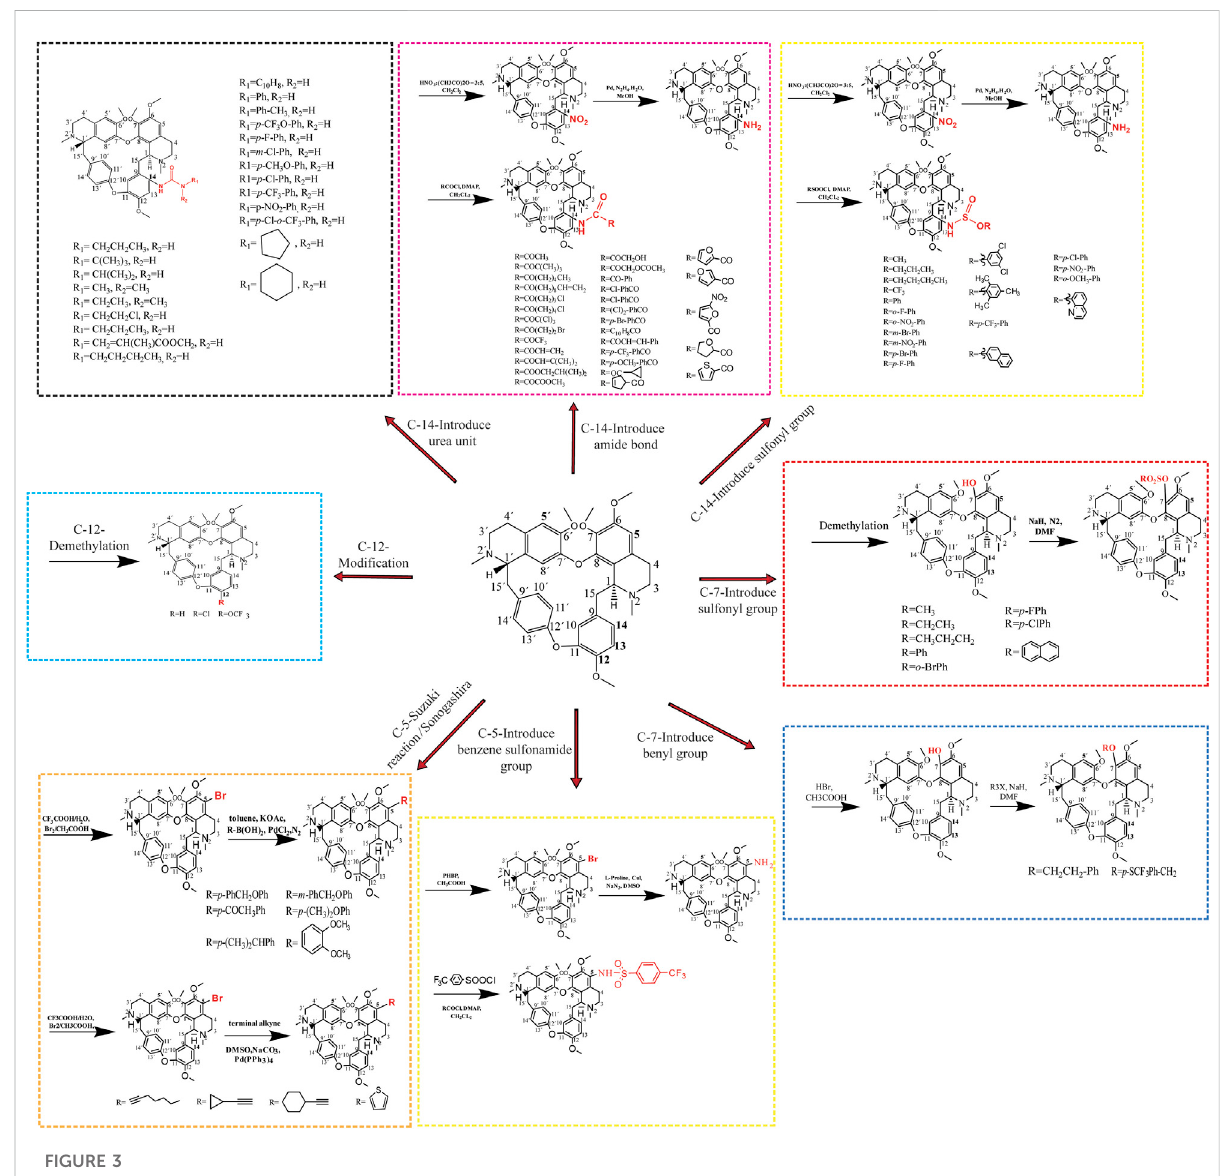
Modi fi cation of the chemical structure of